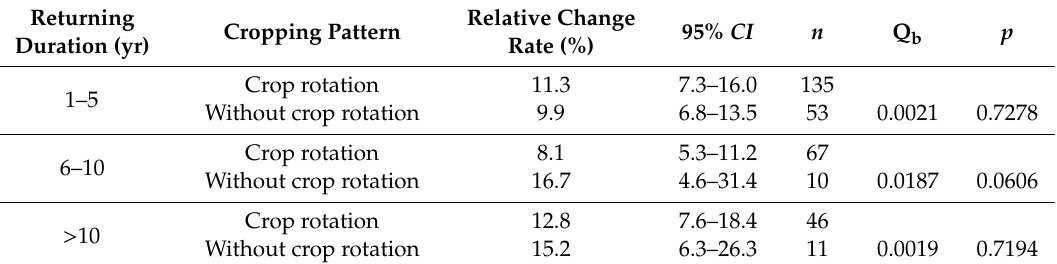
Table 2. Relative change rate of SOC storage responding to cropping pattern in different returning duration under RR.